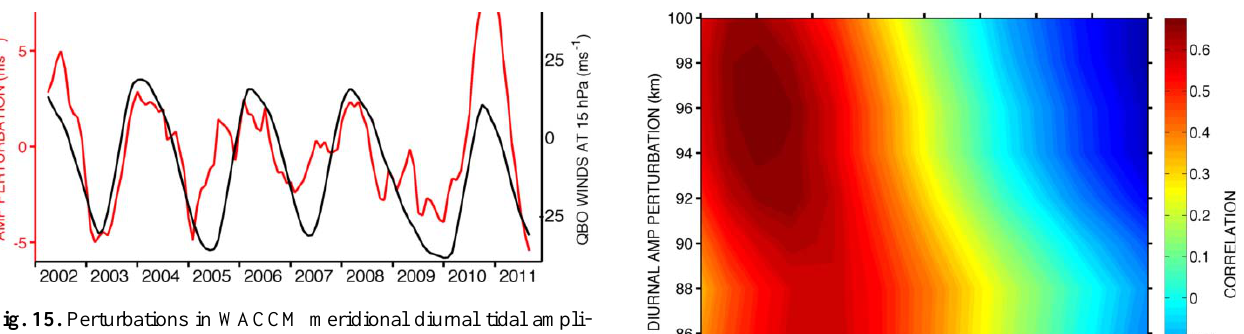
Fig. 15. Perturbations in WACCM meridional diurnal tidal ampli- tudes (calculated by subtracting the composite-year monthly mean from each individual month) at heights near 96km (red line) for 2002–2011. Also plotted are the QBO background winds at 15hPa (black line). The diurnal tidal amplitude perturbations and back- ground winds are smoothed with a seven-month running mean. Note the two different axes, with the red axis on the left corresponding to the WACCM diurnal tidal amplitude perturbations and the black axis on the right corresponding to the QBO line.